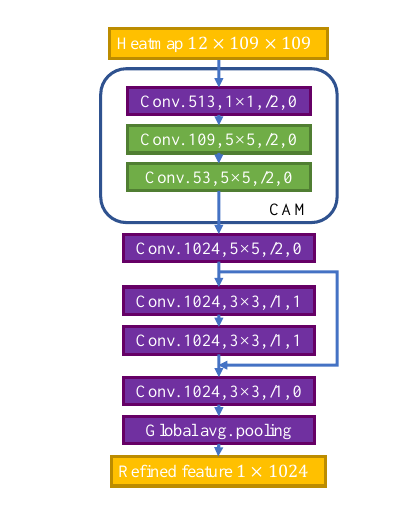
Figure 4. Architecture of encoder for POI with CAM. Purple box is operator from height-width direction and green box is from channel direction as described in section 2.2.2 Numbers in boxes are output channels, kernel size, stride size and padding size.